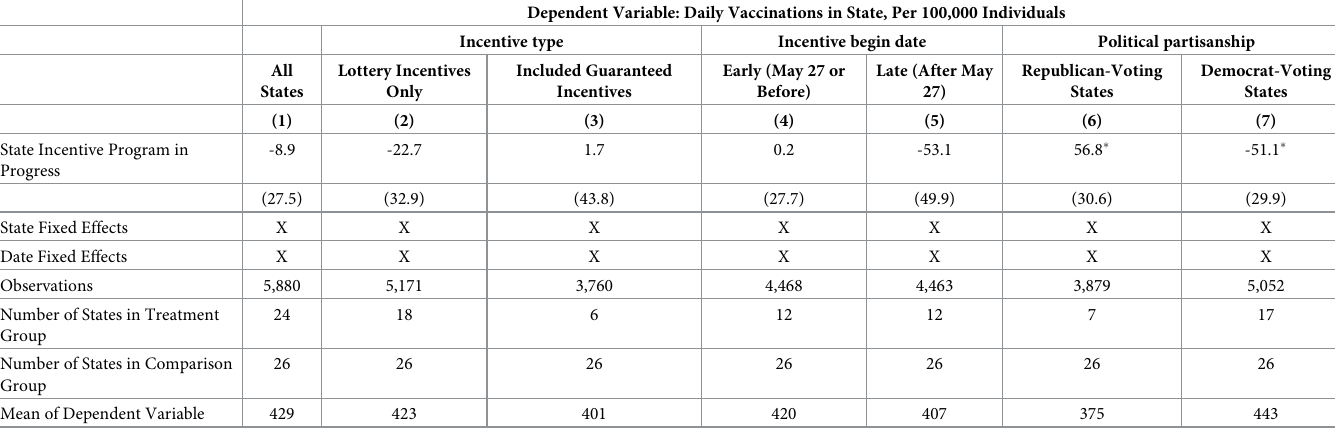
Table 2. Association between statewide incentive programs and vaccination rates, difference-in-difference analysis.